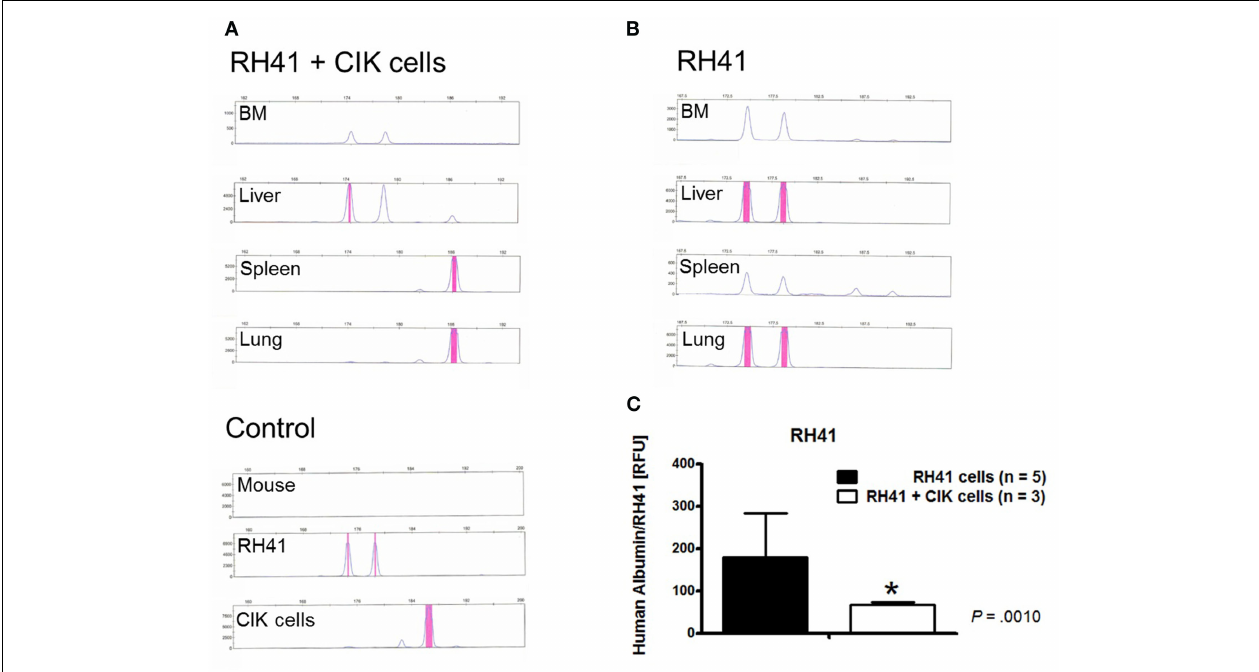
and lung, but was also seen to a lesser extent in the bone marrow (BM) and spleen like shown by one representative untreated control (B) . PCR results from all analyzed organs of the treatment and control group (untreated mice, n = 5; CIK cell treated mice, n = 3) taken together showed, that CIK cells were able to significantly reduce tumor growth when compared to untreated mice [ p < 0.001, (C)